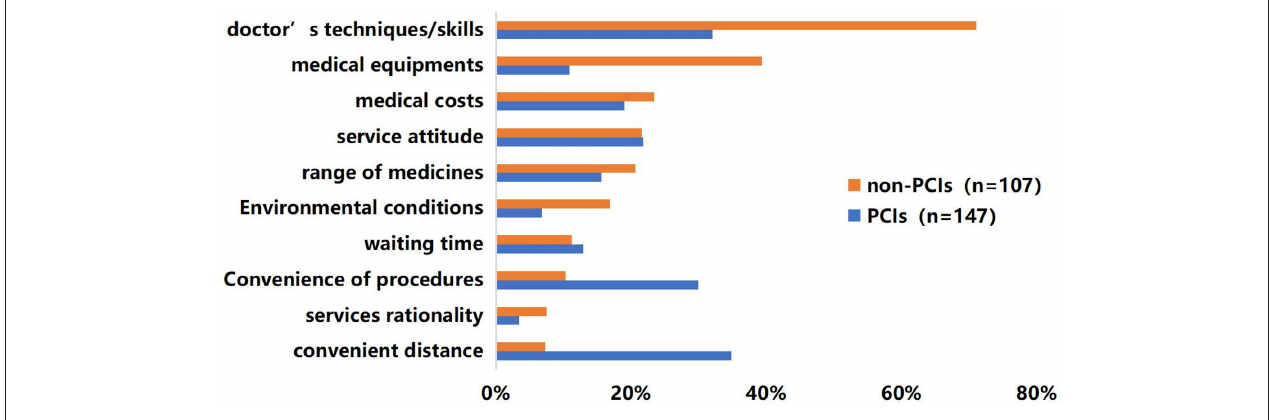
FIGURE 1 | Reasons for first-contact